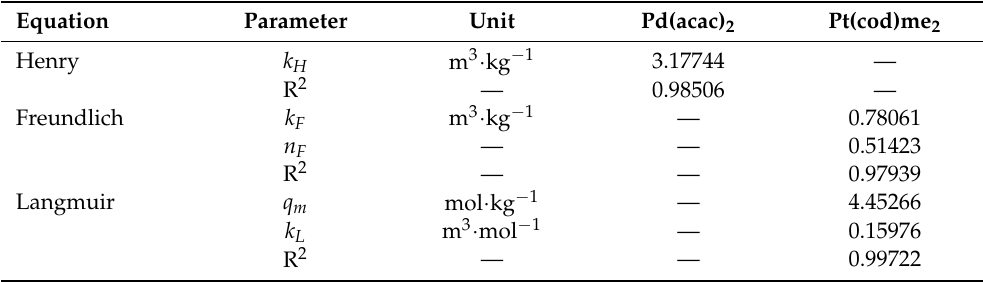
Table 11. Adsorption isotherm parameters for different precursors from scCO 2 solution on BP2000 at 20 MPa and 333 K